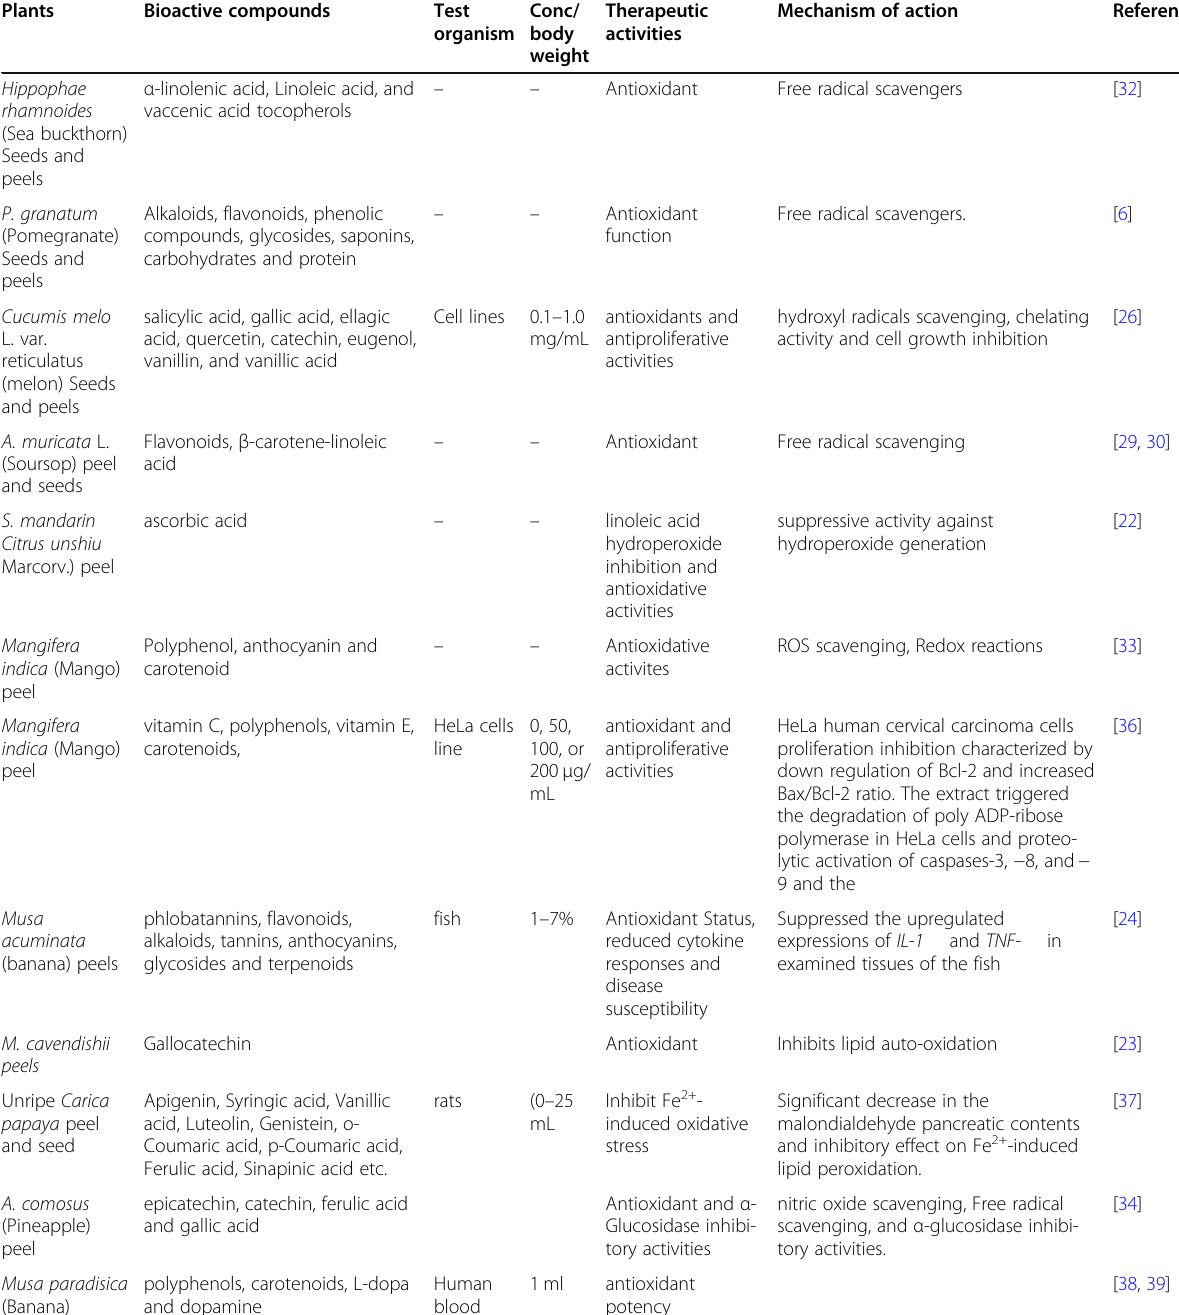
Table 1 Antioxidative properties of some peels and seed extracts